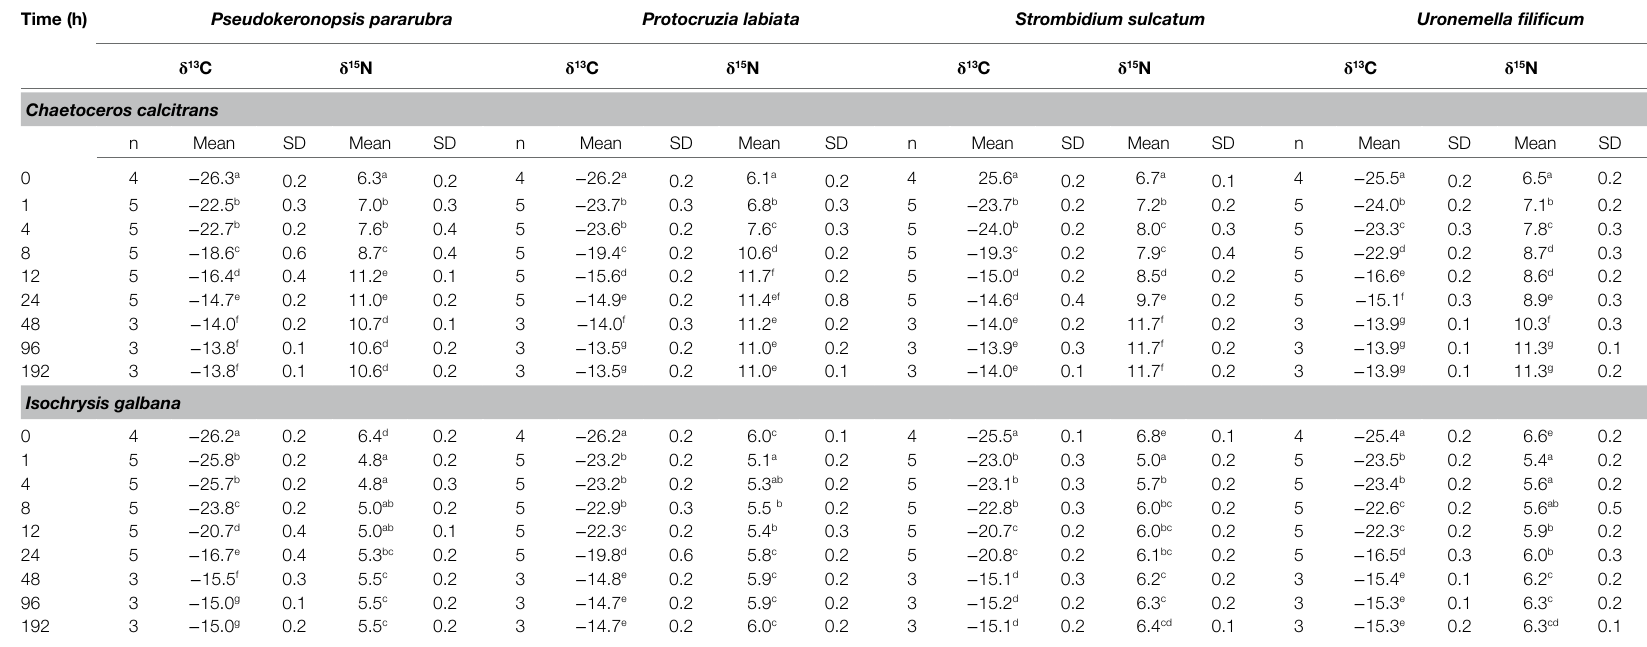
TABLE 2 | Mean δ 13 C and δ 15 N values (‰) of marine ciliates ( Pseudokeronopsis pararubra , Protocruzia labiata , Strombidium sulcatum , and Uronemella filificum ) fed with Chaetoceros calcitrans and Isochrysis galbana during the duration of the entire experiment. Time (h) Pseudokeronopsis pararubra Protocruzia labiata Strombidium sulcatum Uronemella filificum